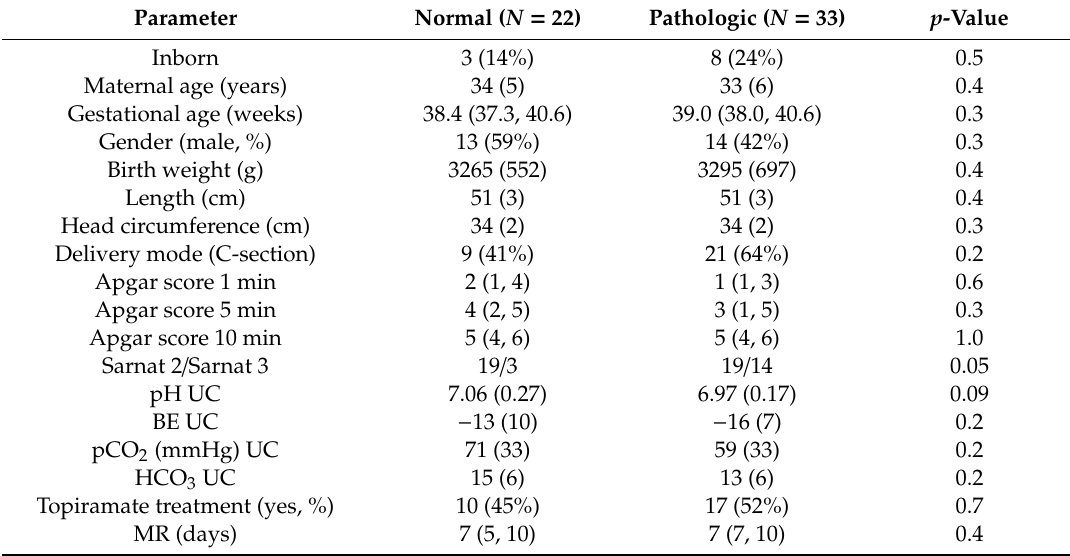
Table 1. Clinical and demographic data of